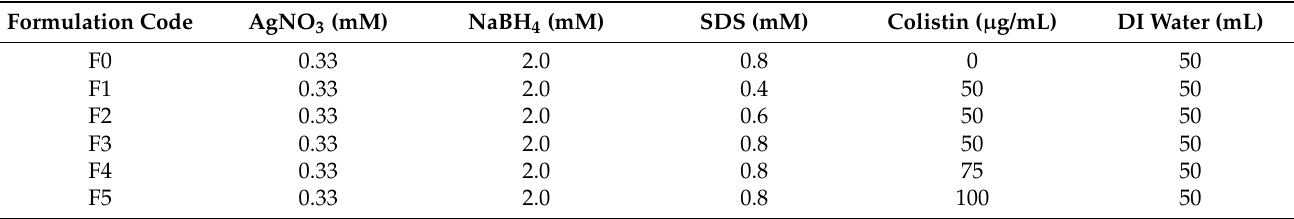
Table 4. Formulations of Col-AgNPs and